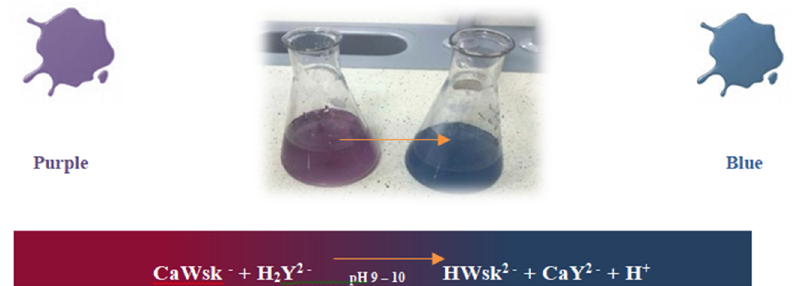
disodium versenate indicator Na 2 H 14 C 10 O 8 N 2 ∙H 2 O, is presented in Figure 13.